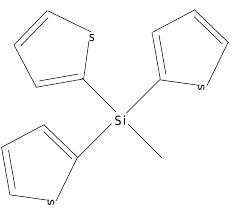
Figure 6. The graph of added branch of organosilicon dendrimer H